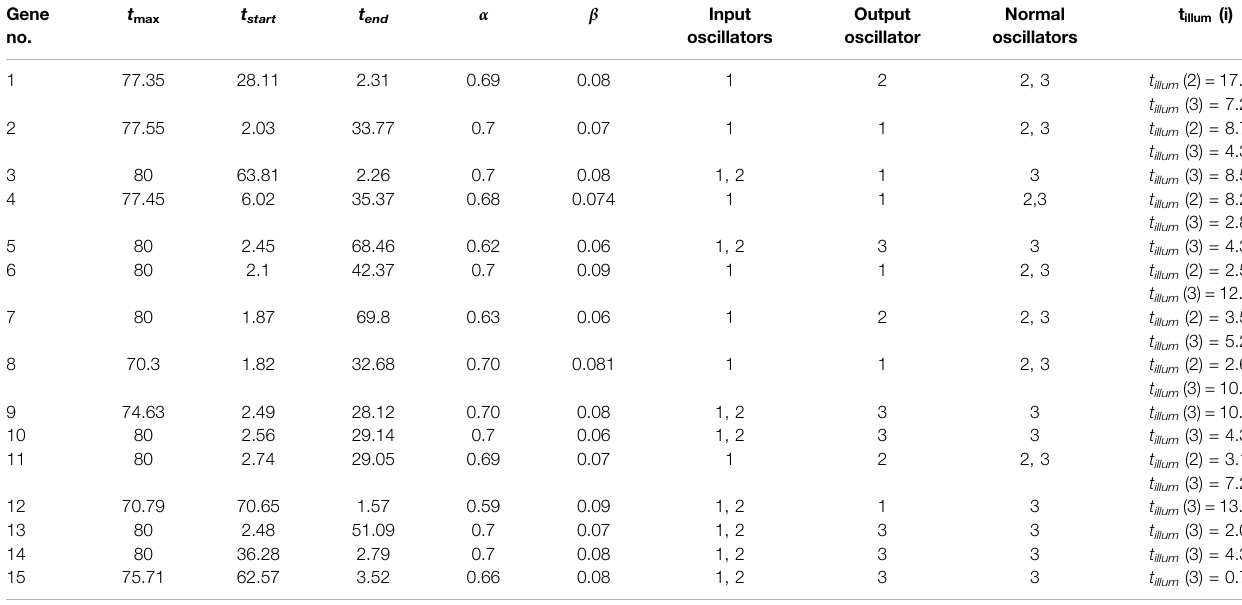
TABLE 3 | The parameters of networks that give the best correlations between the number of activator maxima on the output oscillator and the therapy result. Gene no.